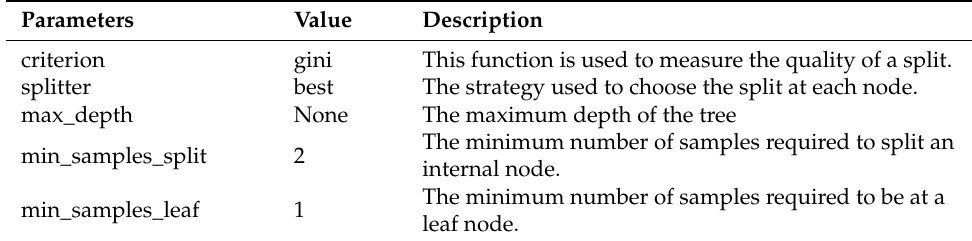
Table 10. Decision tree parameters from scikit-learn library.